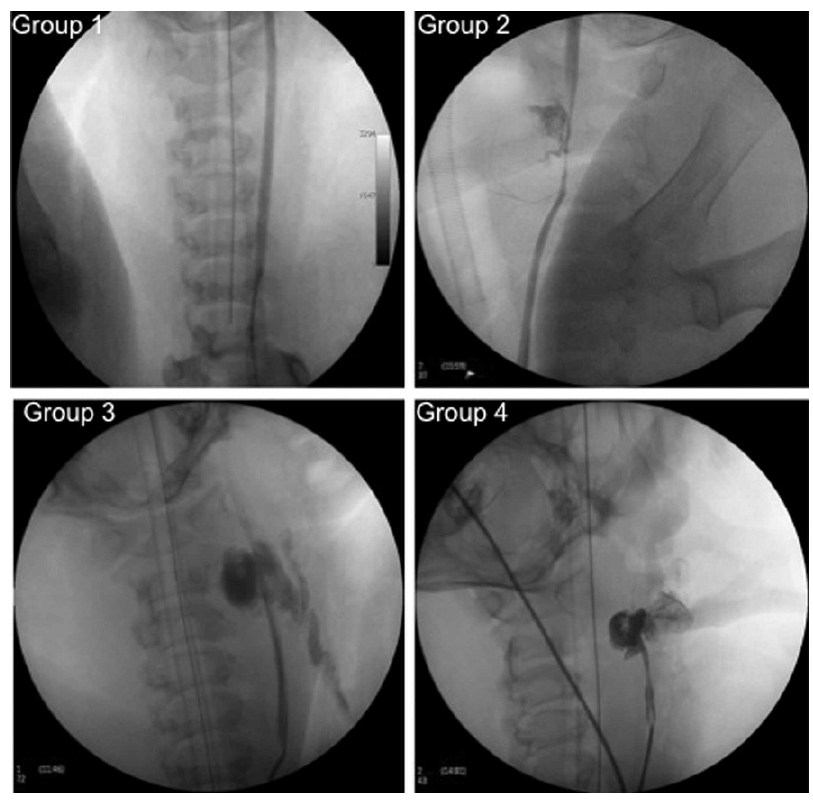
Figure 2 - Lesions confirmed by arteriograms in the